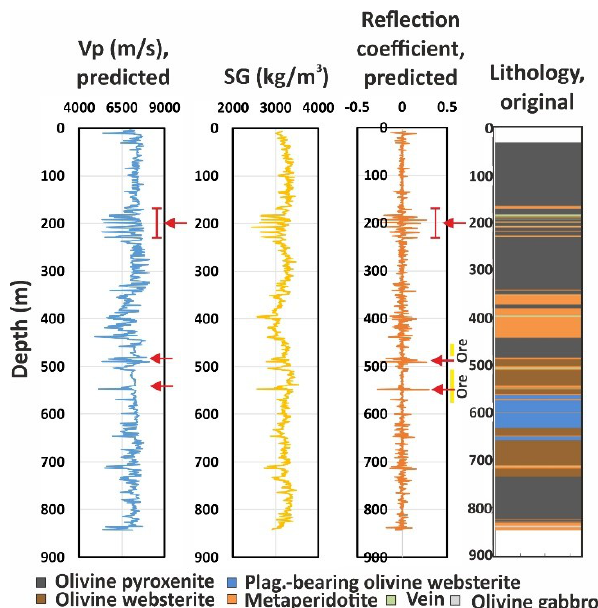
Figure 6. Predicted Vp log, measured SG log and calculated reflection coefficient log derived from predicted Vp and measured SG for borehole KV172 that did not originally contain measurements for seismic velocities. The prediction is from run 9 (Table 2). The last column shows the original lithology for the borehole KV172. Red arrows indicate the reflections discussed within the text.